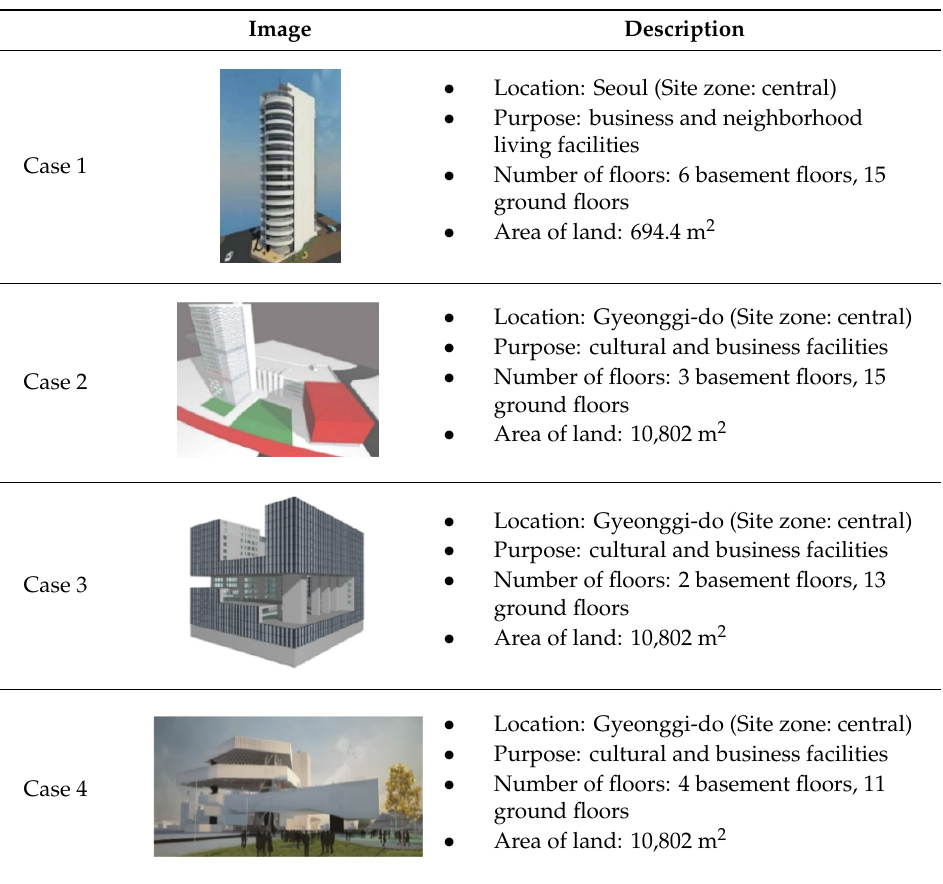
Table 9. The result of quality checking against space check criteria in case models. Space Check Criteria